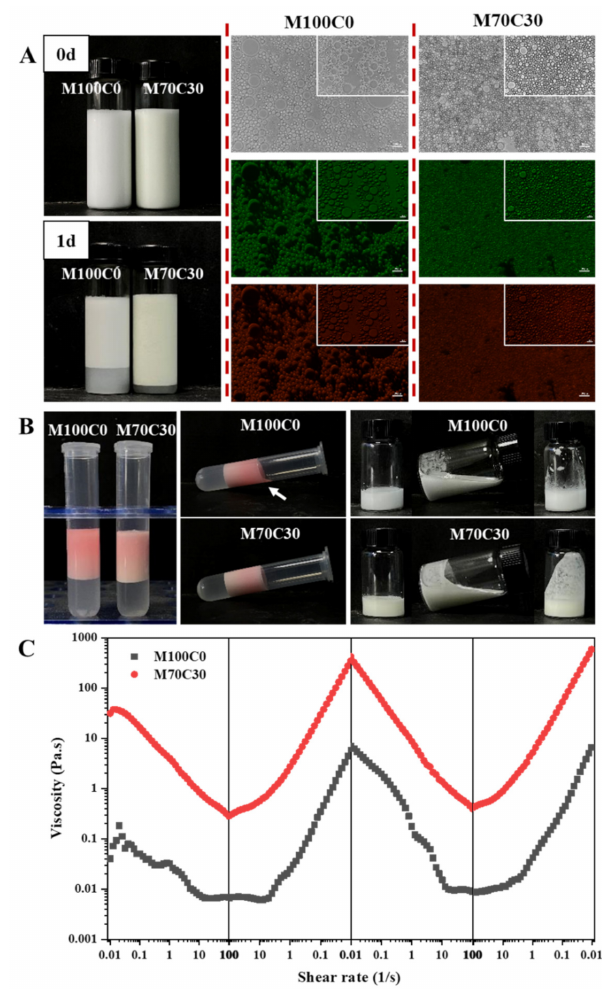
Figure 9. ( A ) Appearance and microstructure of model salad dressing added Na+ and Ca2+ in the presence and absence of CA. The green pictures are FITC-labeled protein and the red pictures are Nile-red-labeled oil phase. The scale bar is 20 µ m. ( B ) The images of model salad dressing centrifugation after dyeing and the wall-cling property. ( C ) Viscosity versus shear rate curves of model salad dressing added Na + and Ca 2+ in the presence and absence of